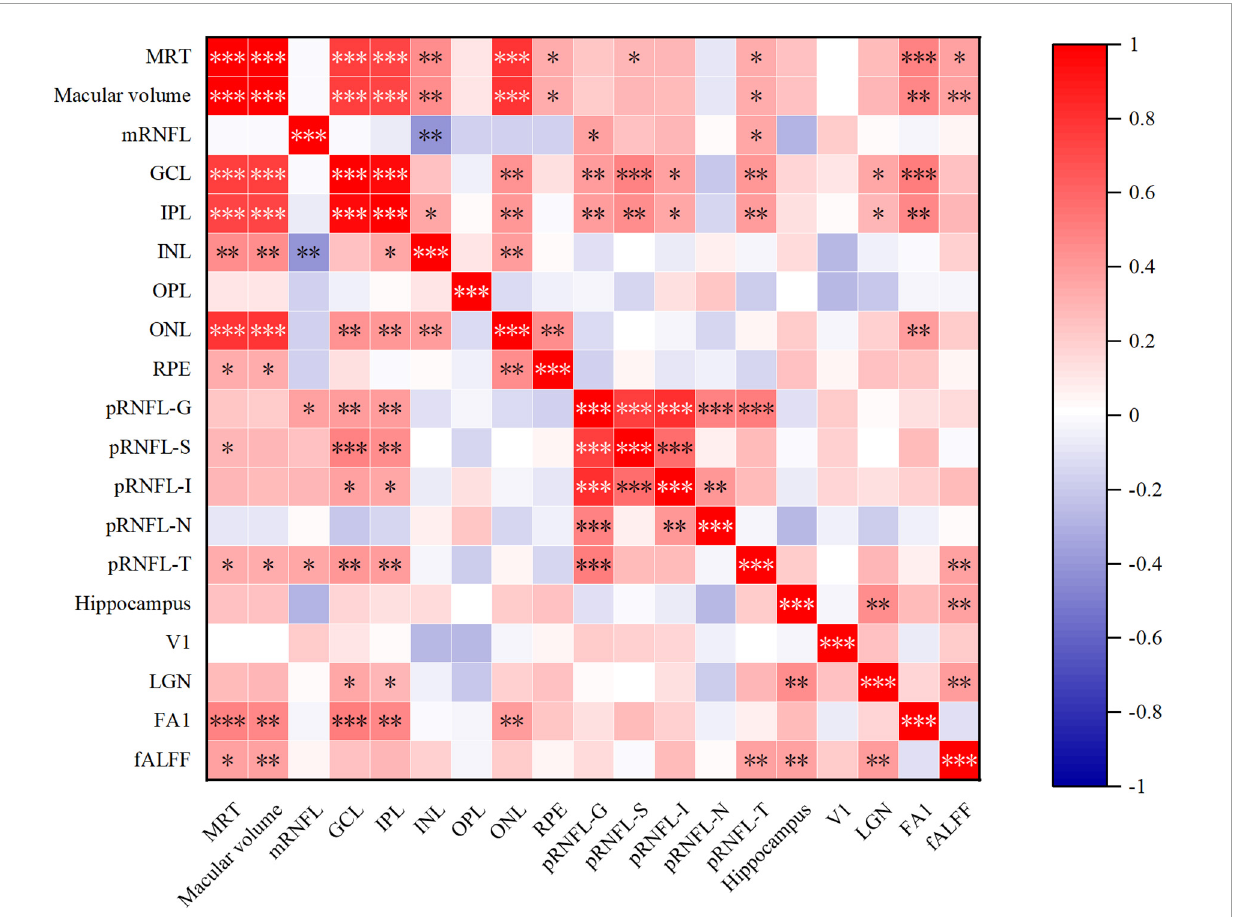
FIGURE4 Heat map of correlation between retinal structure and multimodal MRI in AD group. MRT, mean retinal thickness; mRNFL, macular retinal nerve fiber layer; GCL, ganglion cell layer; IPL, inner plexiform layer; INL, inner nuclear layer; OPL, outer plexiform layer; ONL, outer nuclear layer; RPE, retinal pigment epithelium; pRNFL, peripapillary RNFL; G, global thickness; S, superior quadrant; I, inferior quadrant; N, nasal quadrant; T, temporal quadrant; V1, primary visual cortex; LGN, lateral geniculate nucleus; FA1, fractional anisotropy value of optic tract; fALFF, fractional amplitude of low frequency fluctuations. ∗ p < 0.05, ∗∗ p < 0.01, and ∗∗∗ p <